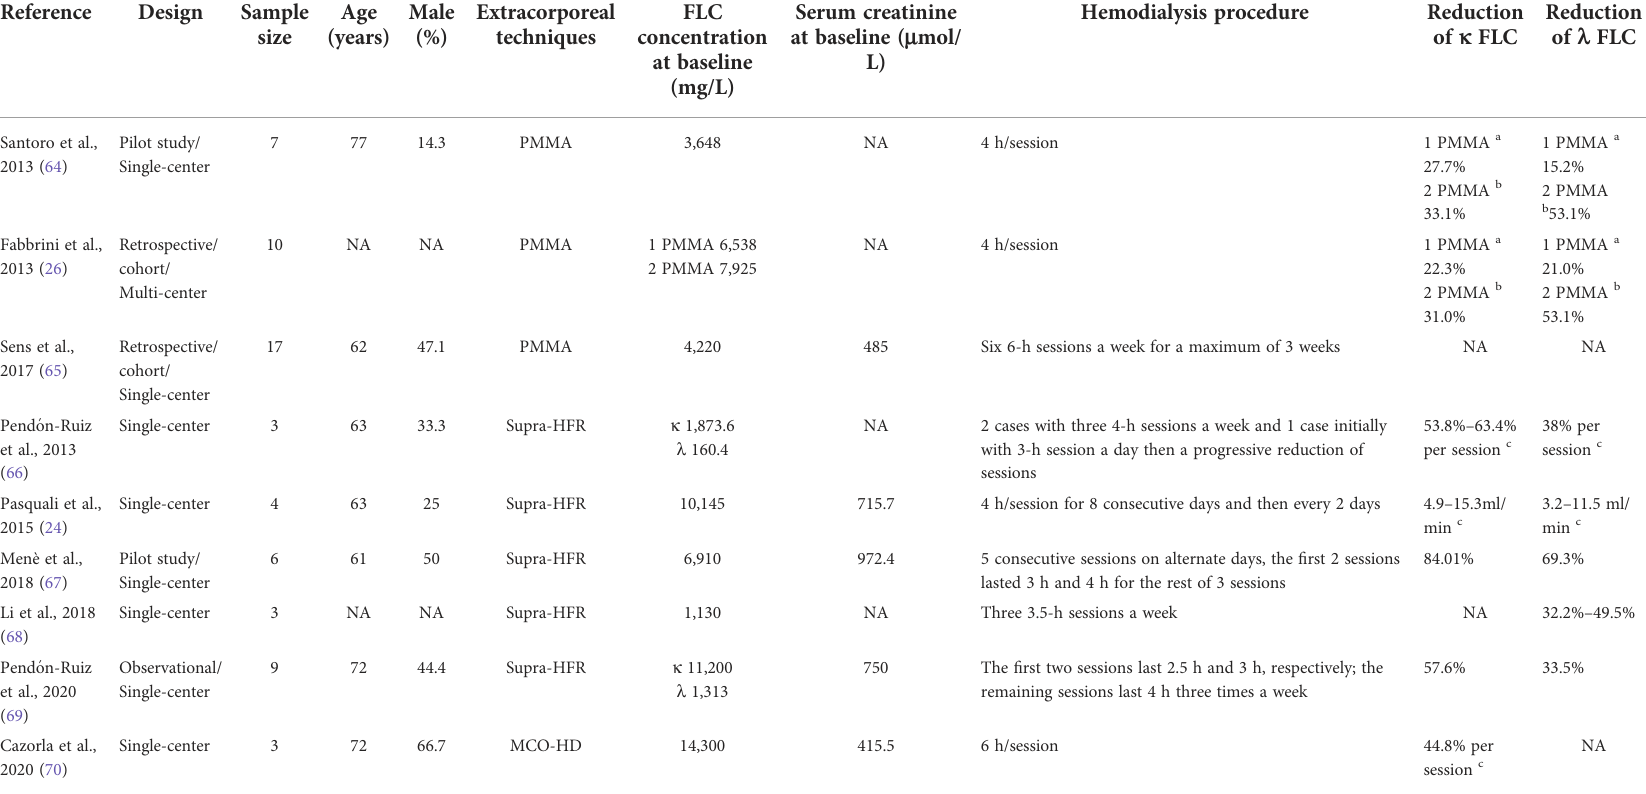
TABLE 4 Other extracorporeal techniques can be available to reduce